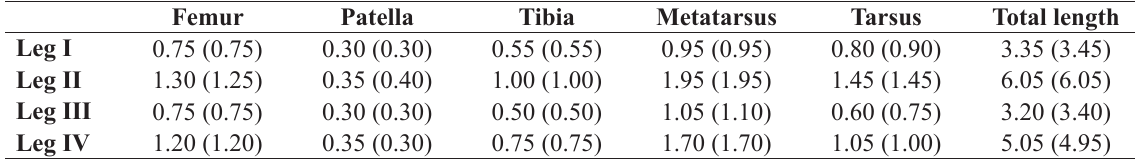
Table 4. Length of appendage-segments in millimeters (trochanters not presented) in N. bidentatum sparsum Gruber & Martens, 1968 from Sonnenberg, Austria: ♂ holotype (♀) (from Gruber & Martens